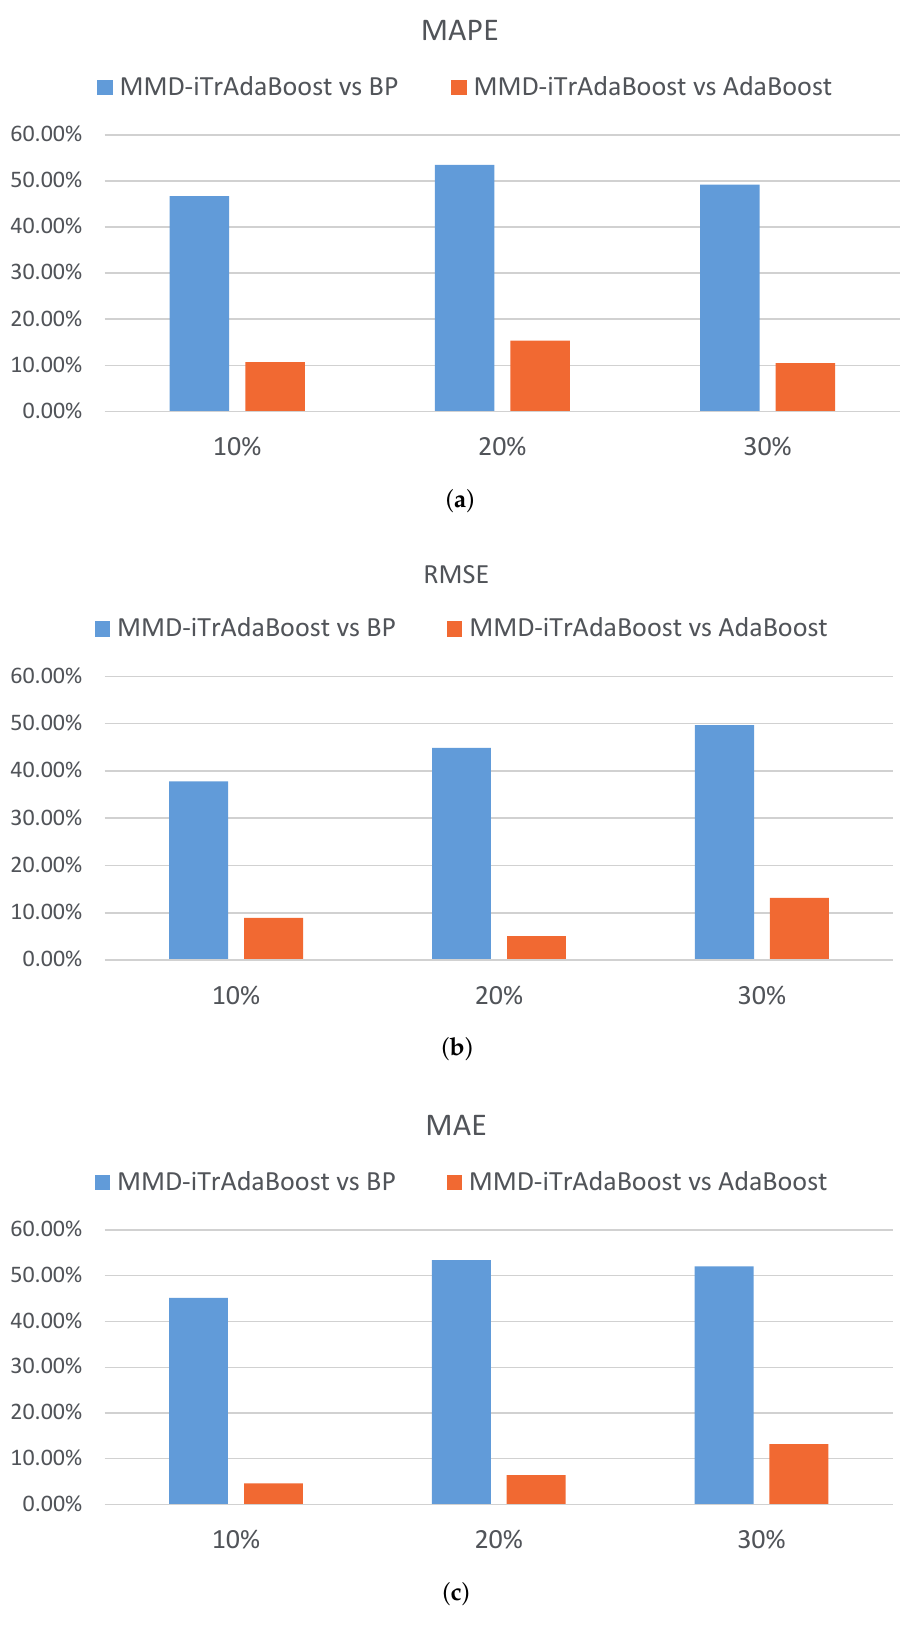
Figure 7. Performance improvements in the proposed model compared with BP and AdaBoost models under three ratios of target-domain training data: ( a ) MAPE, ( b ) RMSE and ( c )